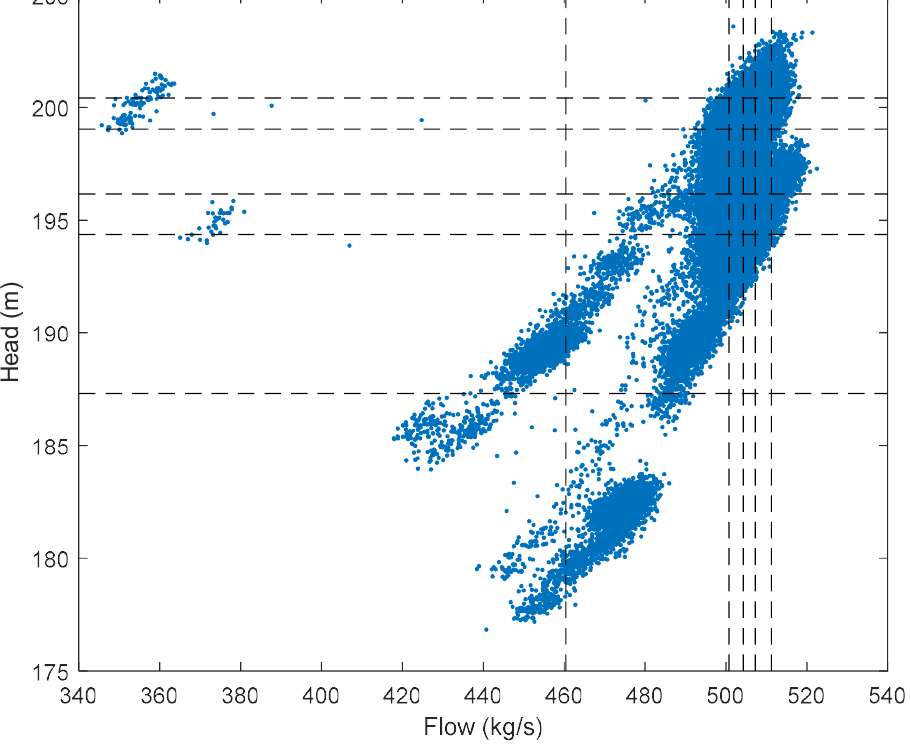
Figure 6. Operational pump curve data for only the station’s normal operating state. Dashed lines represent the 5th, 25th, 50th, 75th, and 95th percentiles of flow and head. The level of variation for normal operation is notable as is the movement between different quantile regions with some pairings never occupied.